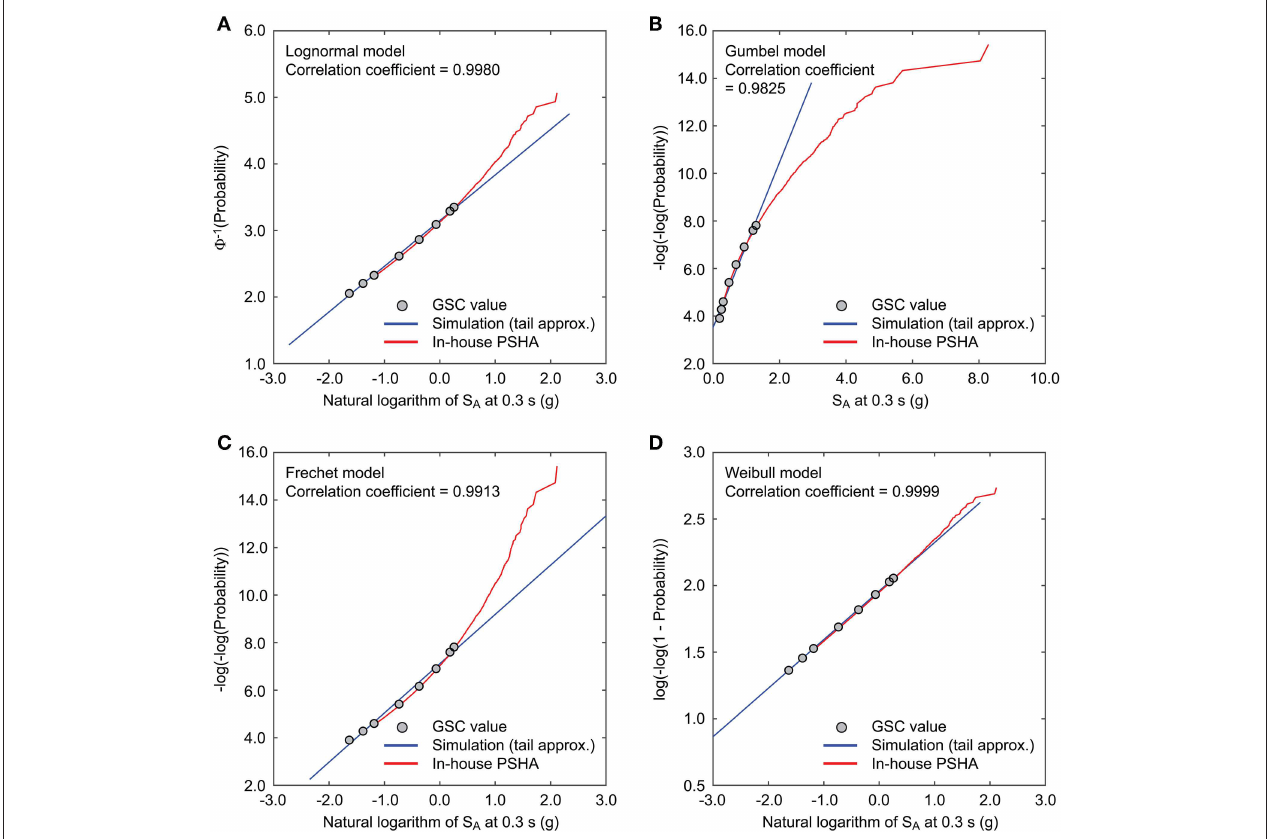
FIGURE 4 | Probability paper plot of PSHA results: (A) lognormal distribution, (B) Gumbel distribution, (C) Frechet distribution, and (D) Weibull